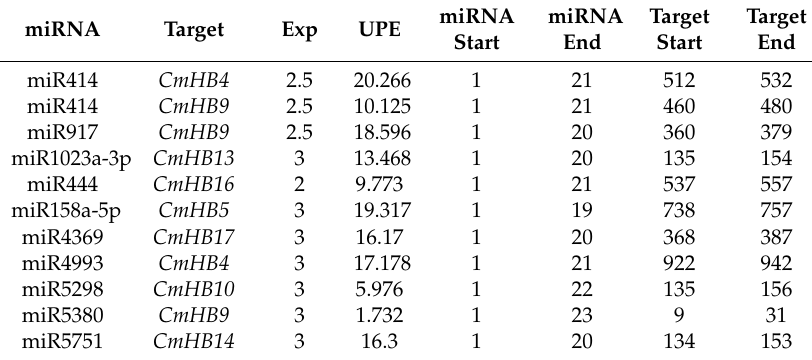
Table 2. The target prediction of miRNA.